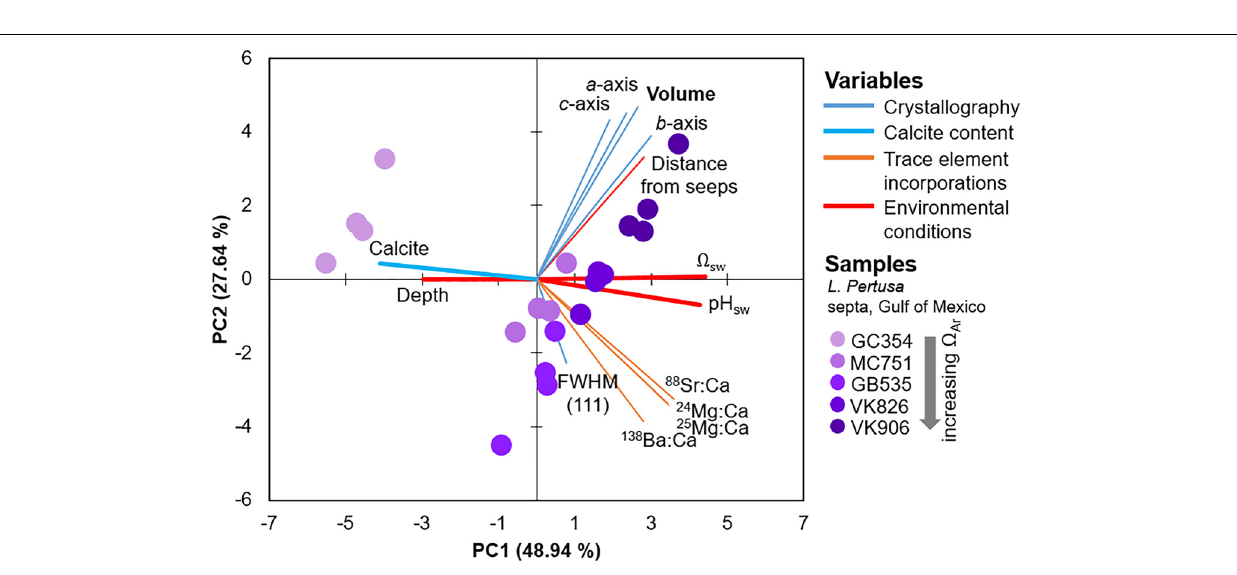
Frontiers in Marine Science |